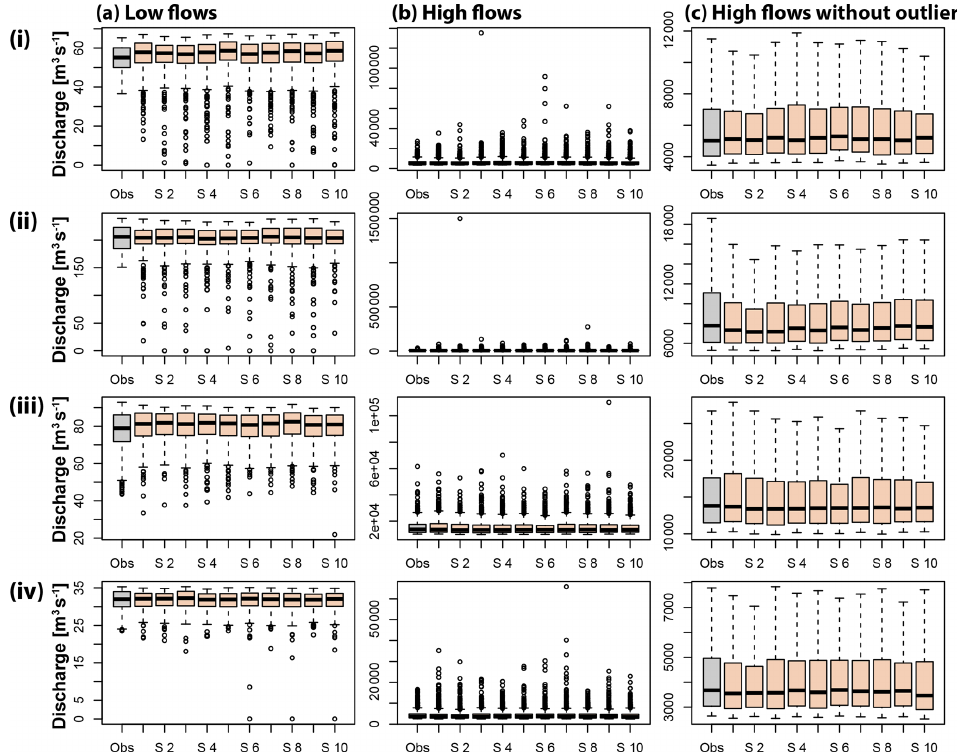
Figure 5. Comparison of observed (grey) (a) low- and (b, c) high-flow distributions (with and without outliers) with simulated distribu- tions of 10 runs (orange) for the four catchments in the Pacific Northwest: (i) Calawah River near Forks, WA (USGS 12043000, id 590),